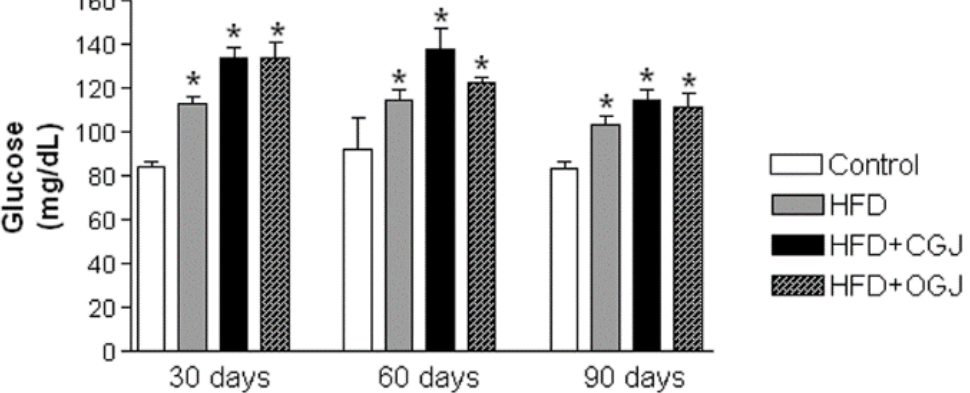
Figure 2. Effect of chronic treatment with high-fat diet and purple grape juice on the capillary glucose levels of rats. Values are means ± SEM for 8–10 samples in each group expressed as mg/dL. Statistically significant differences were determined by ANOVA followed by Bonferroni test: * p < 0.05, from control. HFD: high-fat diet; CGJ: conventional grape juice; OGJ: organic grape juice.